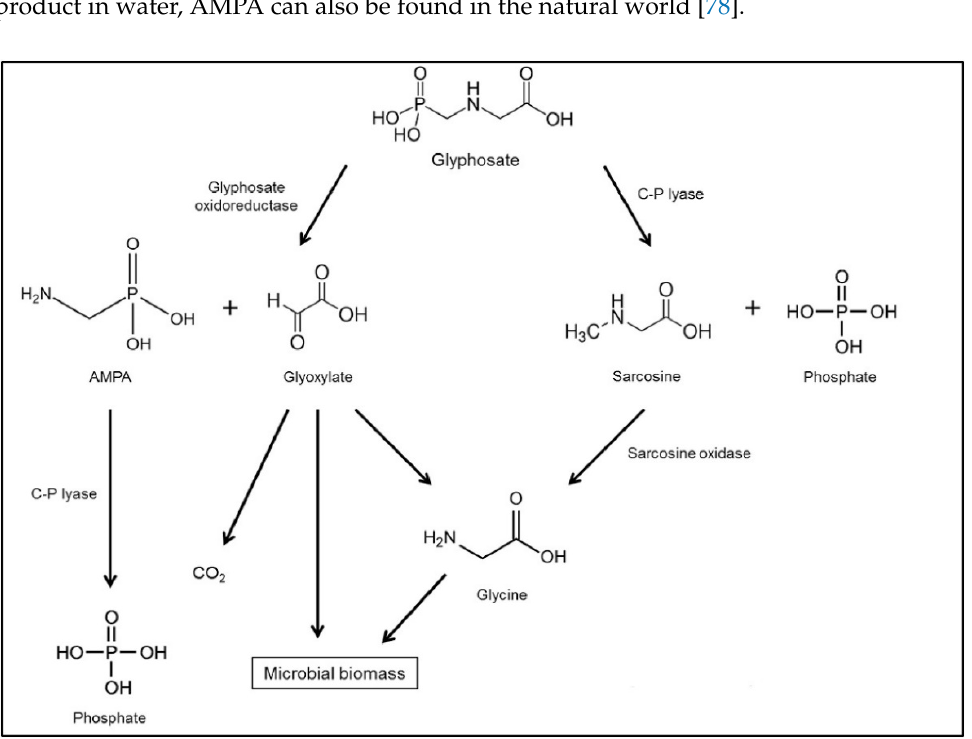
Figure 1. Biodegradation pathways of glyphosate in the environment [14].